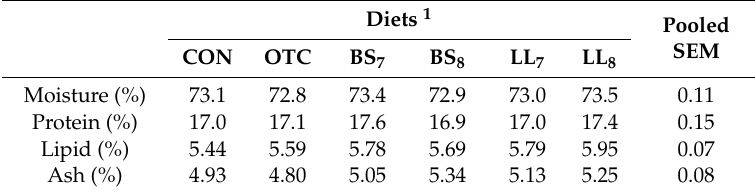
Table 4. Whole-body proximate composition (%, wet weight basis) of juvenile Nile tilapia fed the experimental diets for 8